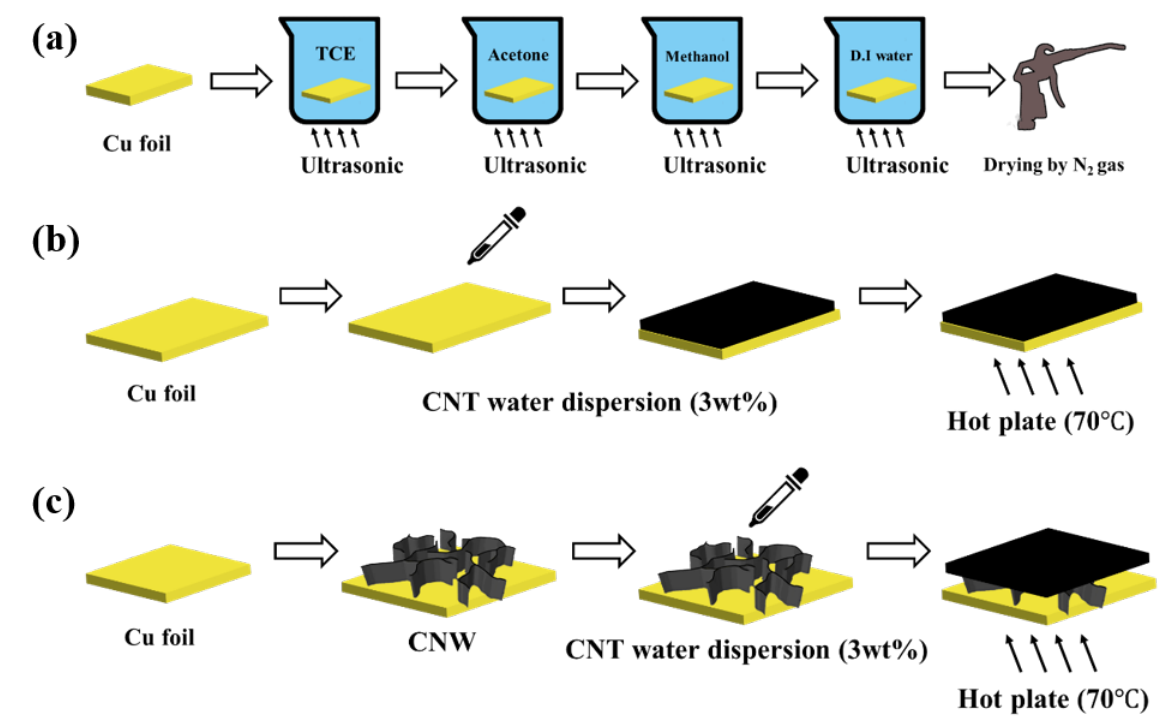
Figure 1. ( a ) The schematic diagram of the Cu foil cleaning process, ( b ) synthesizing the CNT using water dispersion method and ( c ) synthesizing the composite material with CNW and CNT.